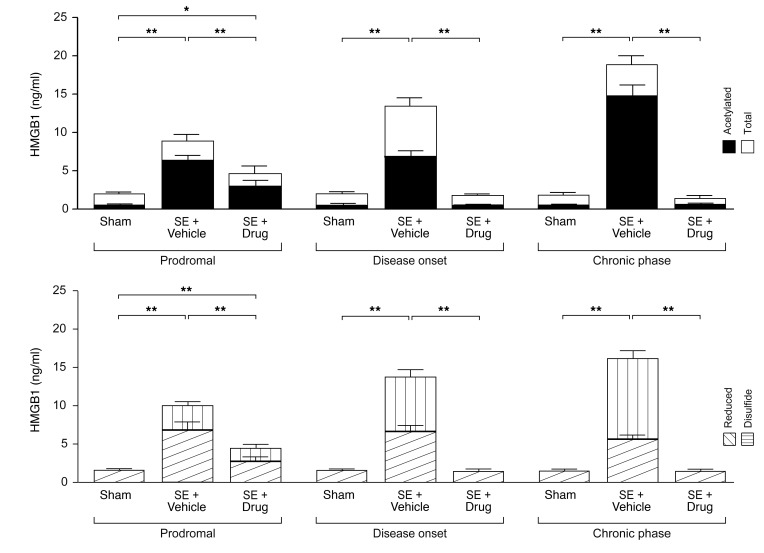
Blood HMGB1 levels increase before epilepsy onset in electrical SE–exposed rats and predict therapeutic response to antiinflammatory drugs.Longitudinal analysis of total HMGB1 and levels of acetylated, reduced, and disulfide isoforms in blood plasma at representative time points of disease development in SE-exposed rats receiving treatment (drug) or corresponding vehicle (see key). Treatment included anakinra+BoxA+ifenprodil (SE+drug) (detailed protocol in Methods; Supplemental Figure 5A). Data are shown as mean ± SEM (n = 9 rats each group; dot plots are shown in Supplemental Figure 7). Rats are the same as reported in Figure 3. *P < 0.05; **P < 0.01, 1-way ANOVA (referred to both isoforms in each bar, except for prodromal phase, where P < 0.01 in SE+drug versus SE+vehicle refers only to reduced HMGB1). The acetylated isoform level in the chronic epilepsy phase (SE+vehicle) was significantly different from corresponding levels at disease onset and prodromal phases (P < 0.01, repeated measures 1-way ANOVA). The disulfide isoform (SE+vehicle) level at disease onset and in the chronic epilepsy phase was significantly different from the corresponding level in the prodromal phase (P < 0.05 and P < 0.01, respectively); the disulfide isoform level in the chronic phase was significantly different from the corresponding level at disease onset (P < 0.05, repeated measures 1-way ANOVA).